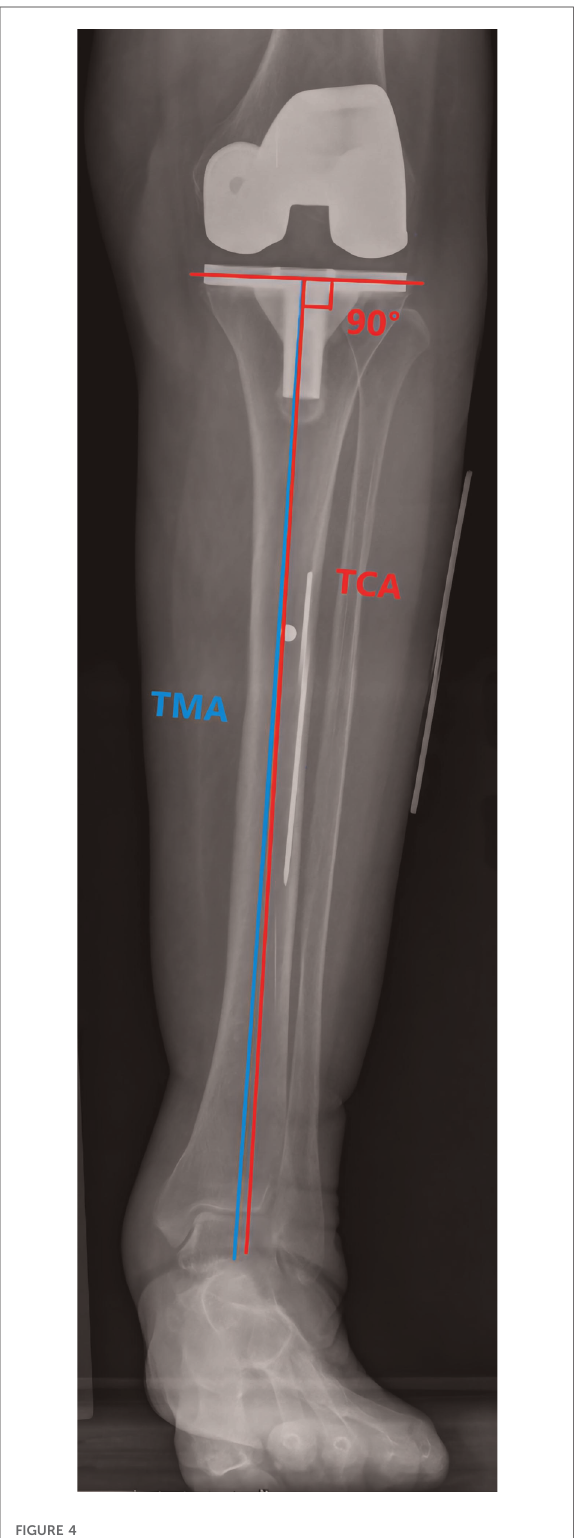
FIGURE 4 The TMA – TCA angle is used to detect the accuracy of the tibial osteotomy. The TCA (red line) is de fi ned as the vertical line through the tibial component tray.